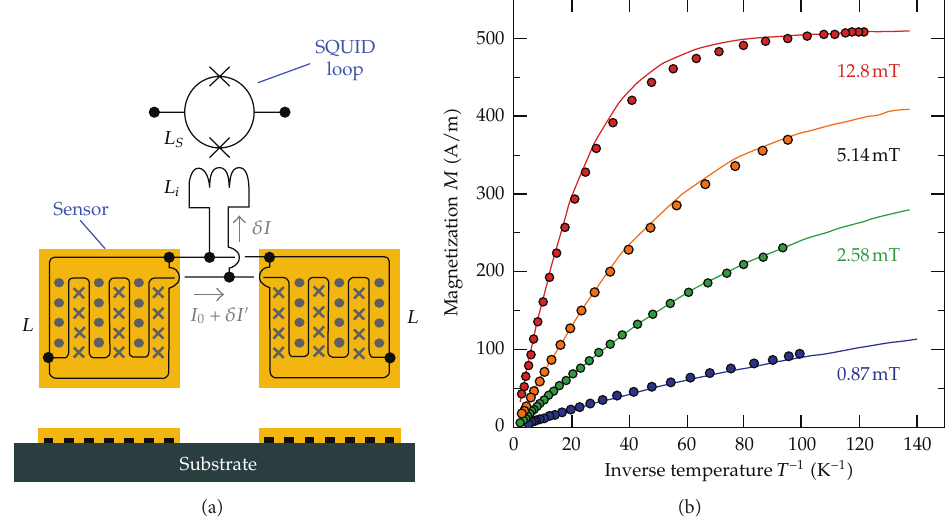
Figure 32: (a) Schematic view of a microstructured MMC type detector. (b) Dependence of the sensor agnetization on the inverse sensor temperature (figures courtesy of Gastaldo